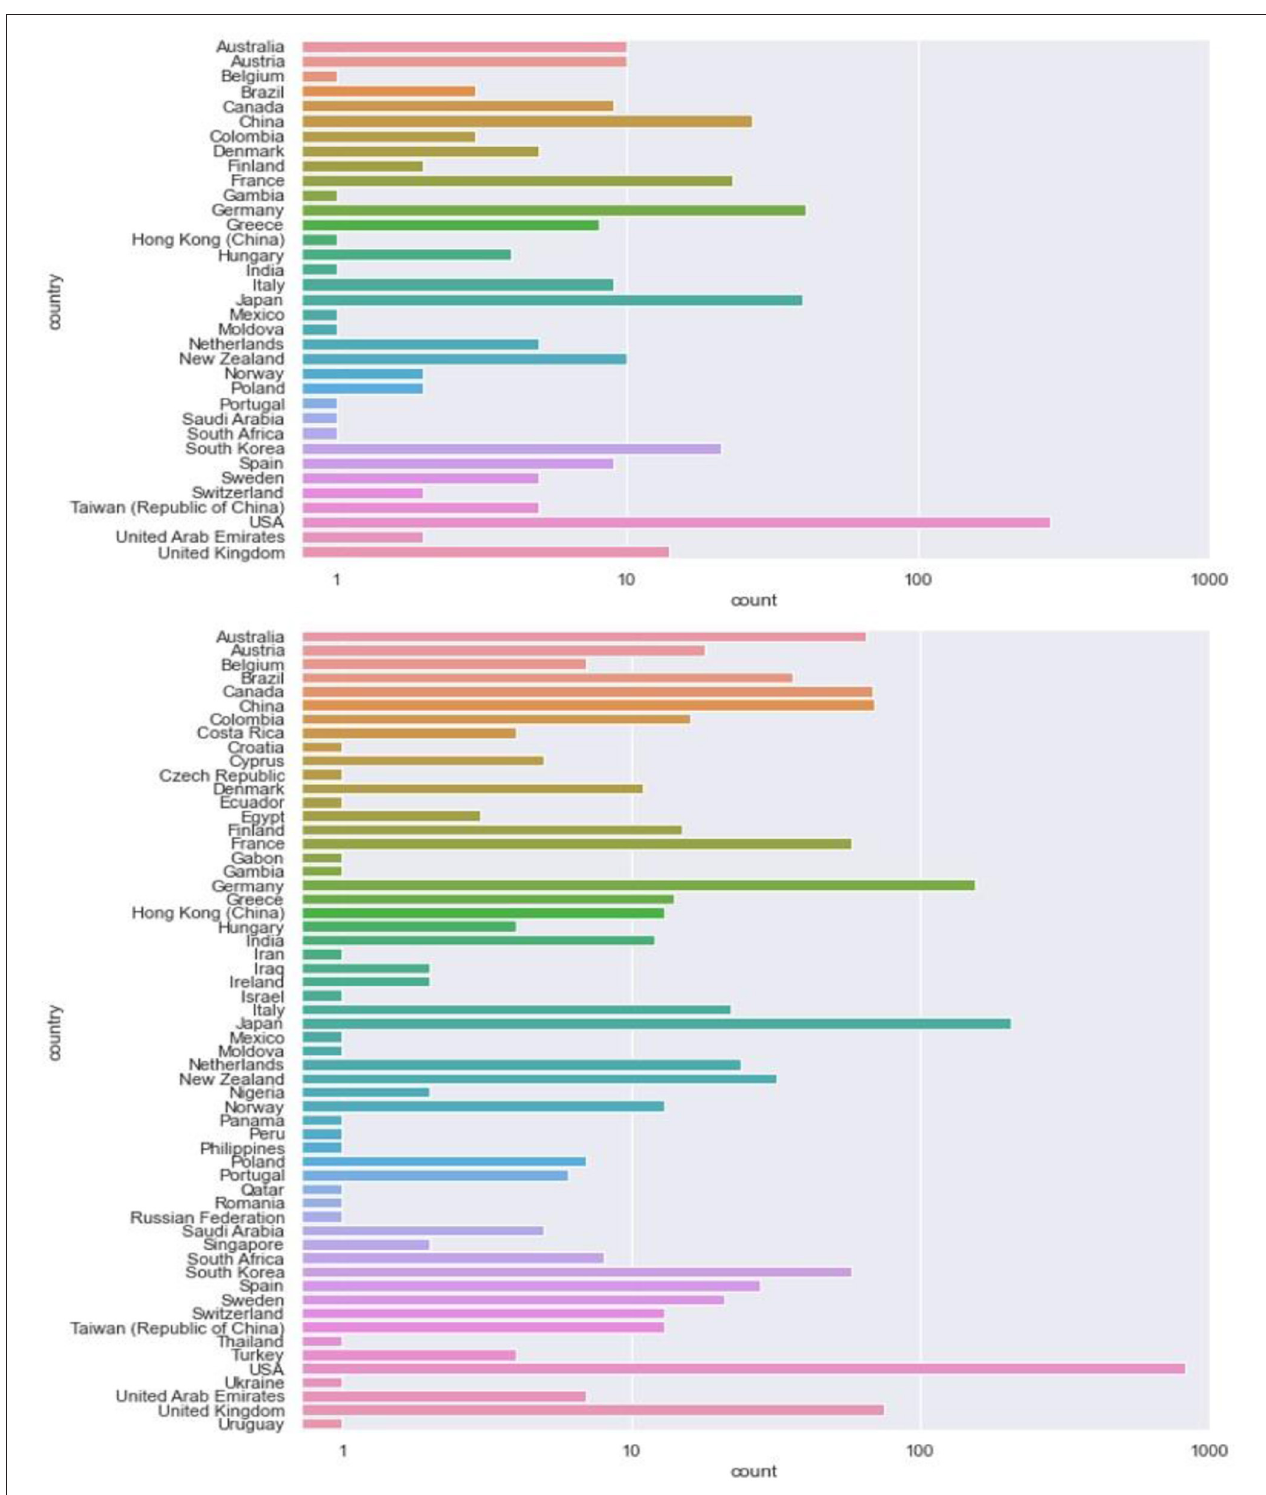
FIGURE 1 | The pool of attendees became substantially more diverse after providing free registration for the conference. Top panel represents home countries of attendees registered before free registration was offered. Bottom panel represents countries of attendees registered after free registration.